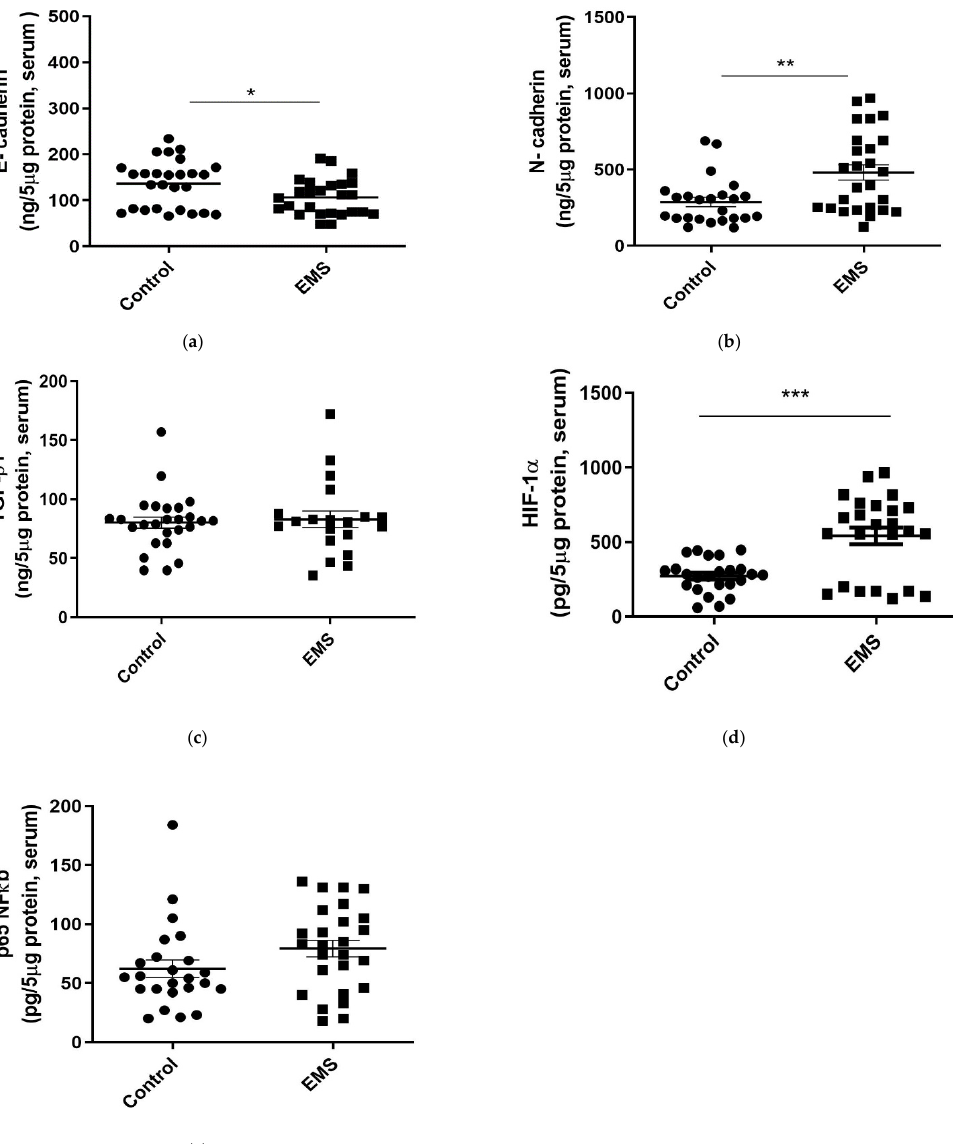
Figure 3. Evaluation of EMT markers (E-cadherin, N-cadherin) and EMT-related inflammatory markers (TGF- β , HIF-1 α , and NF-kB) in serum samples from control and EMS patients (Endo). E-cadherin ( a ), N-cadherin ( b ), TGF- β ( c ), HIF-1 α ( d ), and NF-kB ( e ) levels were assessed by homemade ELISA kits. Data are the mean ± SD of two different experiments, each performed in duplicate. Statistical analysis was performed by unpaired t -test: * p <0.05, ** p <0.01, *** p < 0.001 versus control.